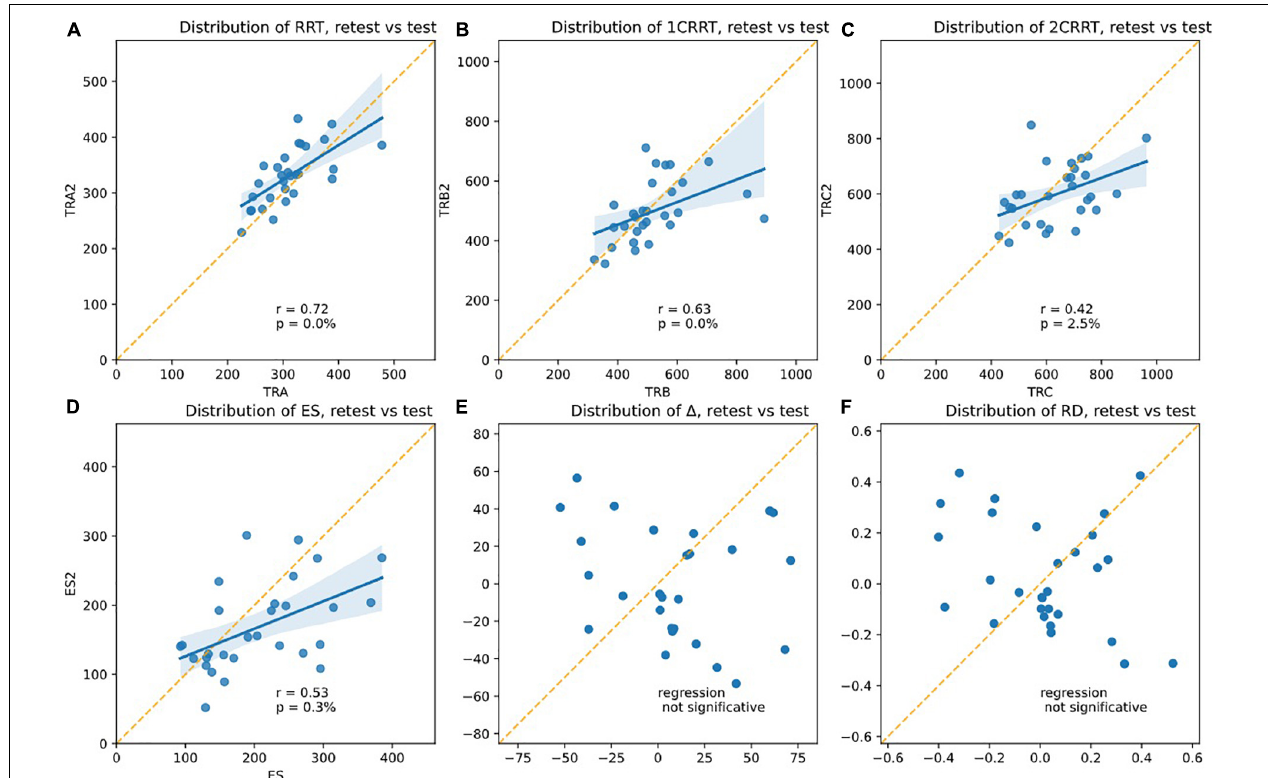
FIGURE 10 | Plotsshowing the test-retest effects. The slope of the linear regression asserts the Pearson r -coefficient. The correlation is significative for (A) RRT, (B) 1CRRT, (C) 2CRRT, (D) ES, and not for (E) Delta and (F) RD. An ideal test would have r = 1 (regression line parallel to the diagonal), but this never happens in any reaction time tests.